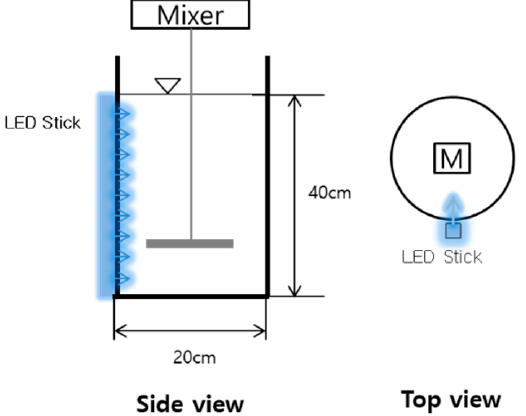
Figure 1. Schematic diagram of the induction photo bioreactor (photo-sequencing batch reactor— PSBR) used in this study.